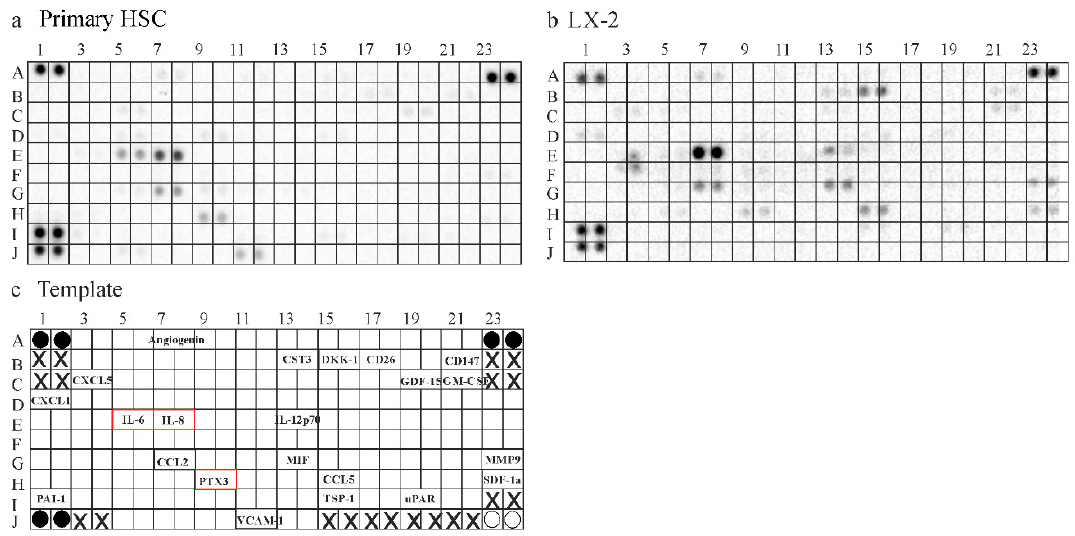
Figure 6. Secretome of HSC and LX-2 cells. ( a ) Hybridization of the human Cytokine Array with supernatant of primary human HSC; ( b ) Hybridization of the human Cytokine Array with supernatant of LX-2 cells; ( c ) Template of the Array: Black circles are the reference spots. White circles are negative controls and X marks positions where no antibodies were spotted. The names of the soluble factors detected by either array are given at the respective position of the Cytokine Array. Proteins, which were further analyzed by ELISA, are in red boxes.